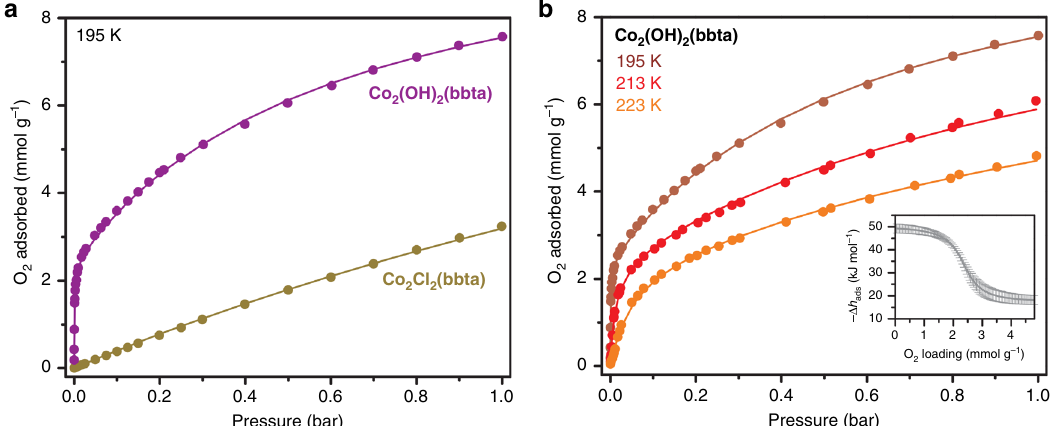
Fig. 3 Oxygen adsorption data. a Oxygen adsorption isotherms obtained at 195 K for Co 2 Cl 2 (bbta) (gold circles) and Co 2 (OH) 2 (bbta) (purple circles). b Oxygen adsorption isotherms obtained at 195, 213, and 223 K for Co 2 (OH) 2 (bbta) (maroon, red, and orange symbols respectively). Symbols represent data points and lines represent fi ts using a dual-site Langmuir model. The inset depicts the differential enthalpy of adsorption for O 2 adsorption in Co 2 (OH) 2 (bbta) (gray line, with error bars), determined using the Clausius – Clapeyron equation as described in the Methods. Source data are provided as a source data fi